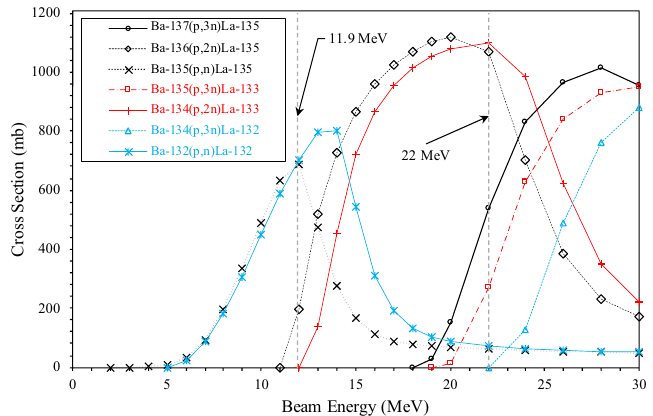
Figure 2. Nuclear reaction cross-section simulation data of the proton-induced nuclear reaction on 132/134/135/136/137 Ba for 132/133/135 La 12